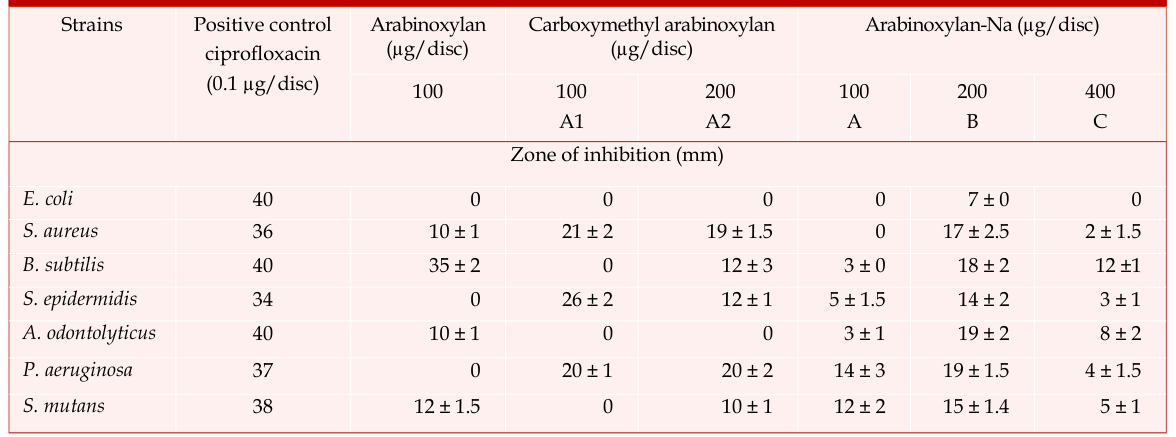
Antimicrobial susceptibility testing of modified arabinoxylans against bacterial